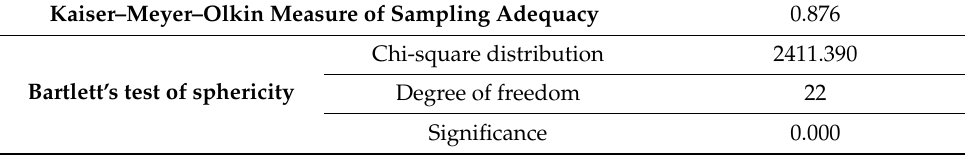
Table 2. KMO and Bartlett’s test of the 10